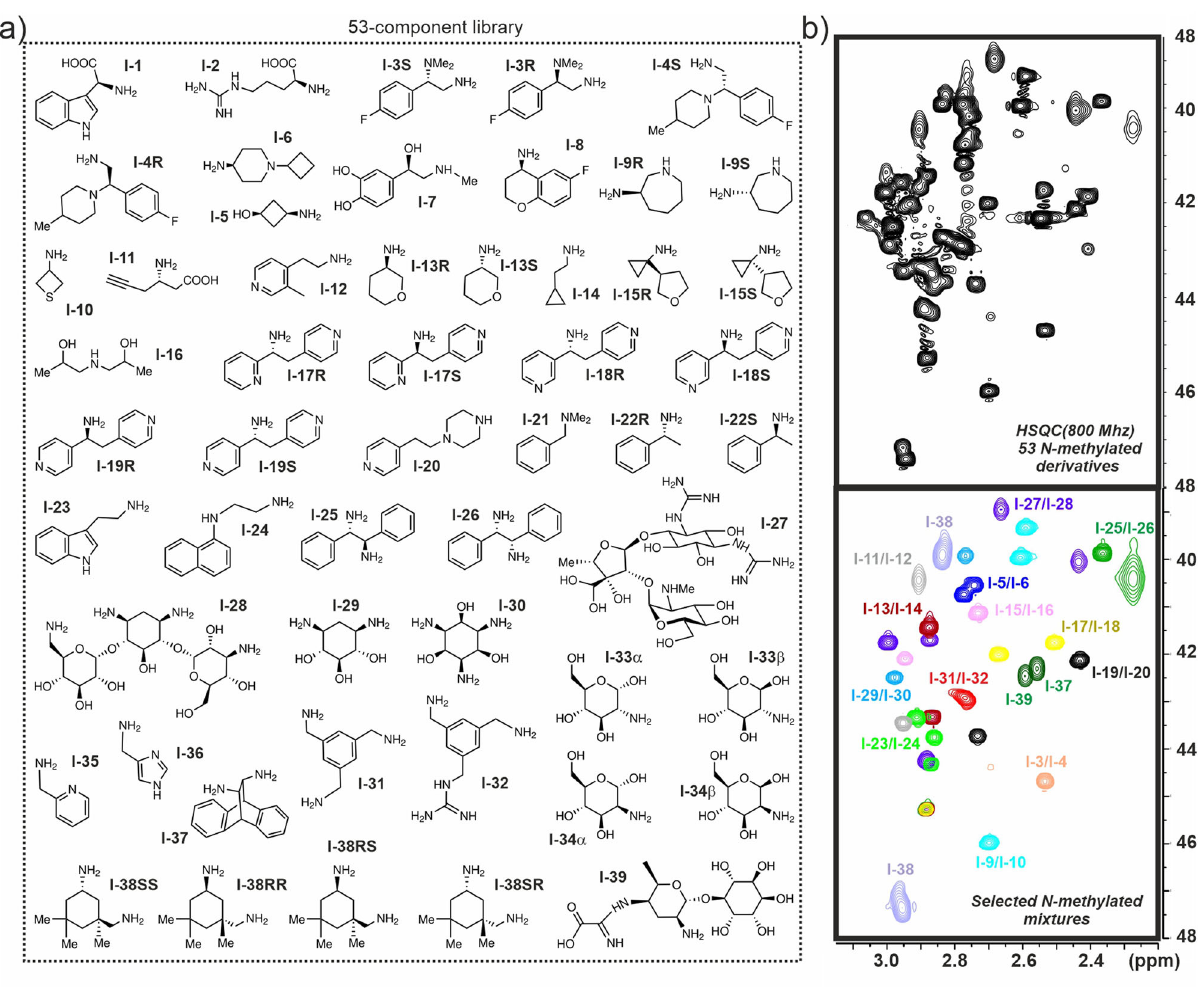
Fig. 6 Library of aminated derivatives. a Library of 53 mono- and polyaminated derivatives employed in our chemical protection assays. b HSQC experiment (pH 7.2) obtained for the 13 C- per-N-methylated library (top) together with a superimposition of HSQC data sets measured for selected pairs of per-N-methylated components for assignment purposes